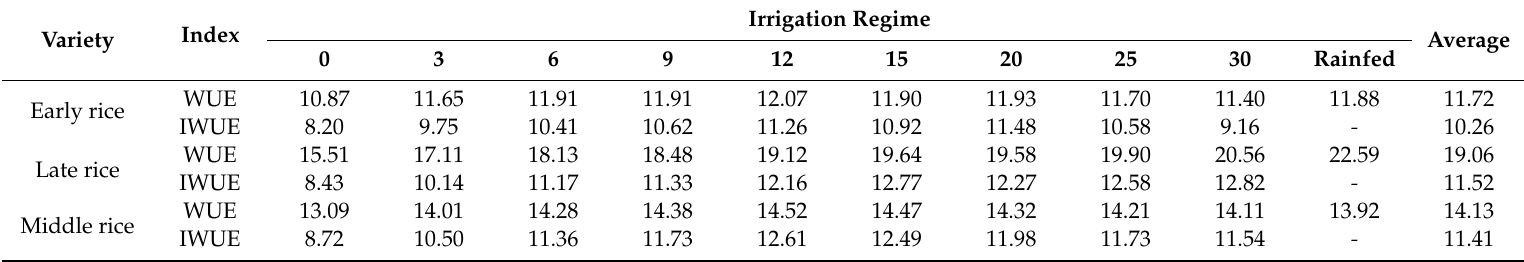
Table 7. Water use e ffi ciency (WUE) (kg grain m − 3 ) and irrigation water use e ffi ciency (IWUE) (kg grain m − 3 ) under di ff erent irrigation regimes (irrigation was applied on di ff erent days after the paddy water layer disappeared) and rainfed condition at critical nitrogen fertilizer level for early rice, late rice, and middle rice during the period of 1981–2015 in the study